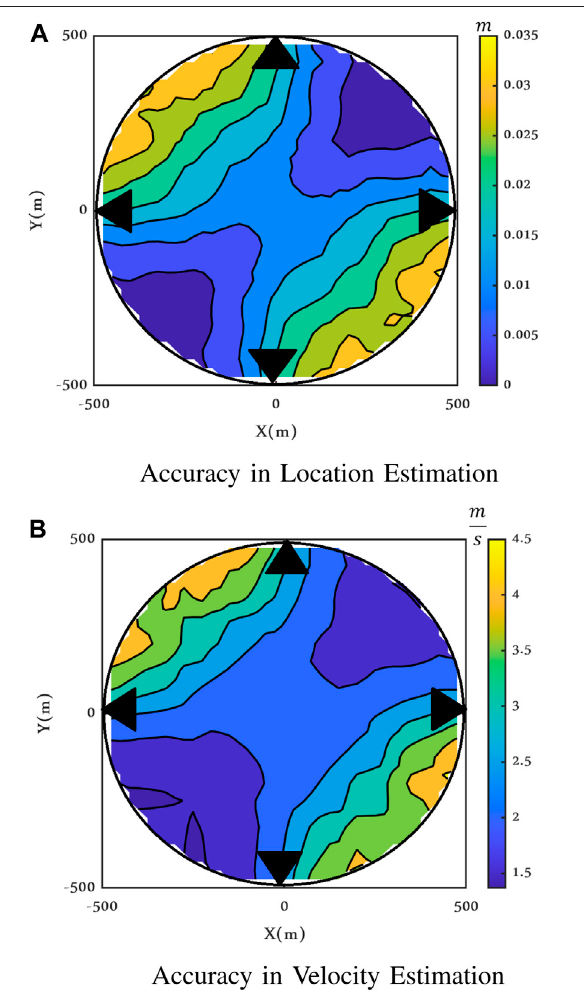
FIGURE 20 | Maximum achievable accuracy when the target is still, Clutter Model II, ρ = 0.9, ] = 2.1, and SCR = − 15 dB.